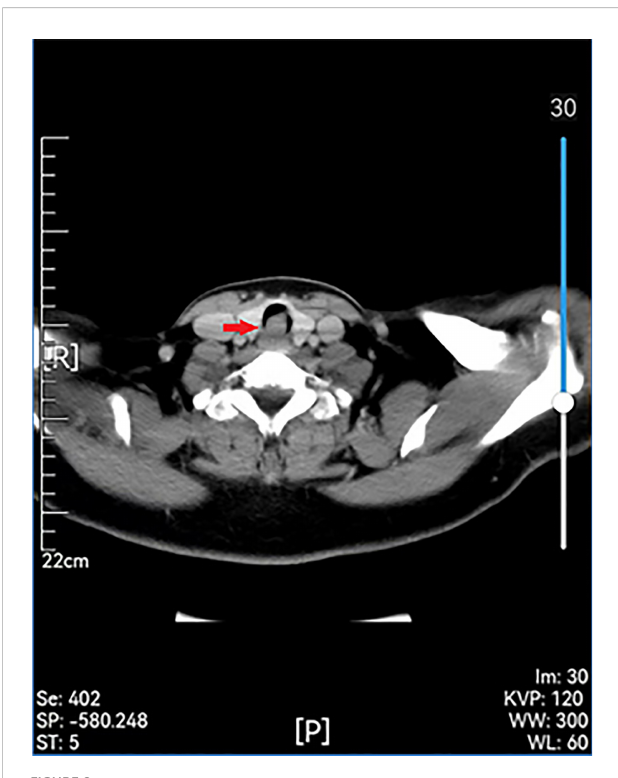
FIGURE 2 Preoperative enhanced CT scan showing a remodeled area of cervical with posterior wall erosion (red